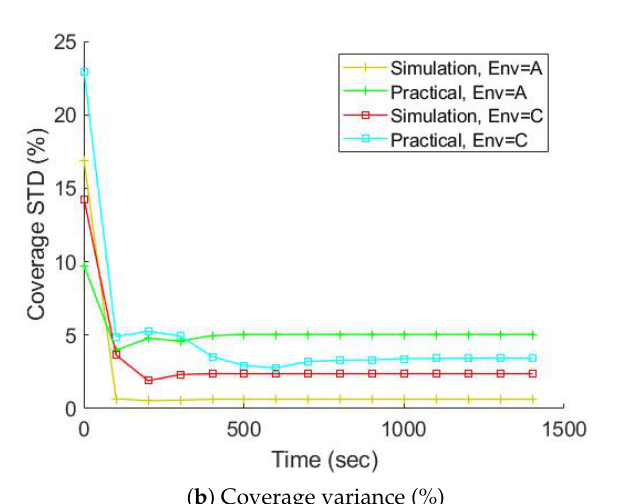
Figure 18. Comparison of the coverage of the radiation covering map from the simulation, and from using the real robot, average over ten trials.